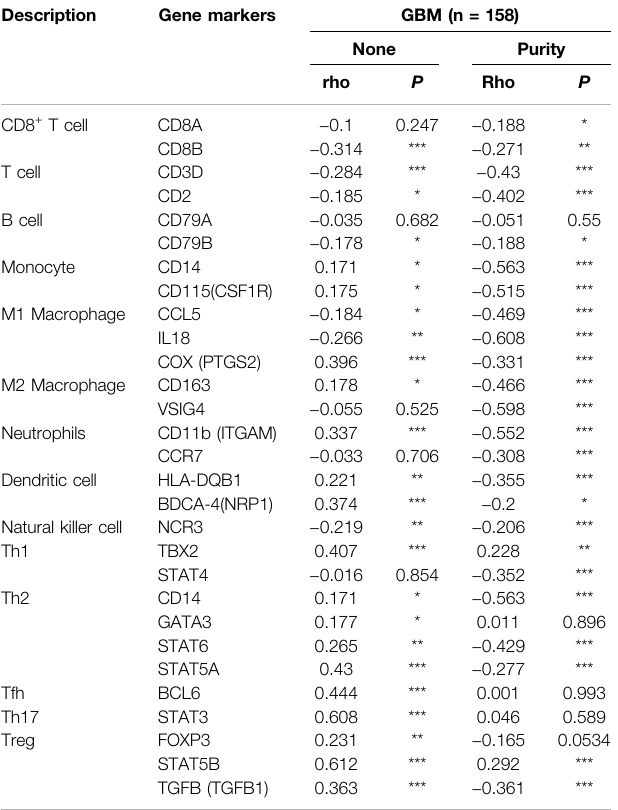
TABLE 5 | Correlation analysis between PLAGL2 and related genes of immune cells in TIMER database.